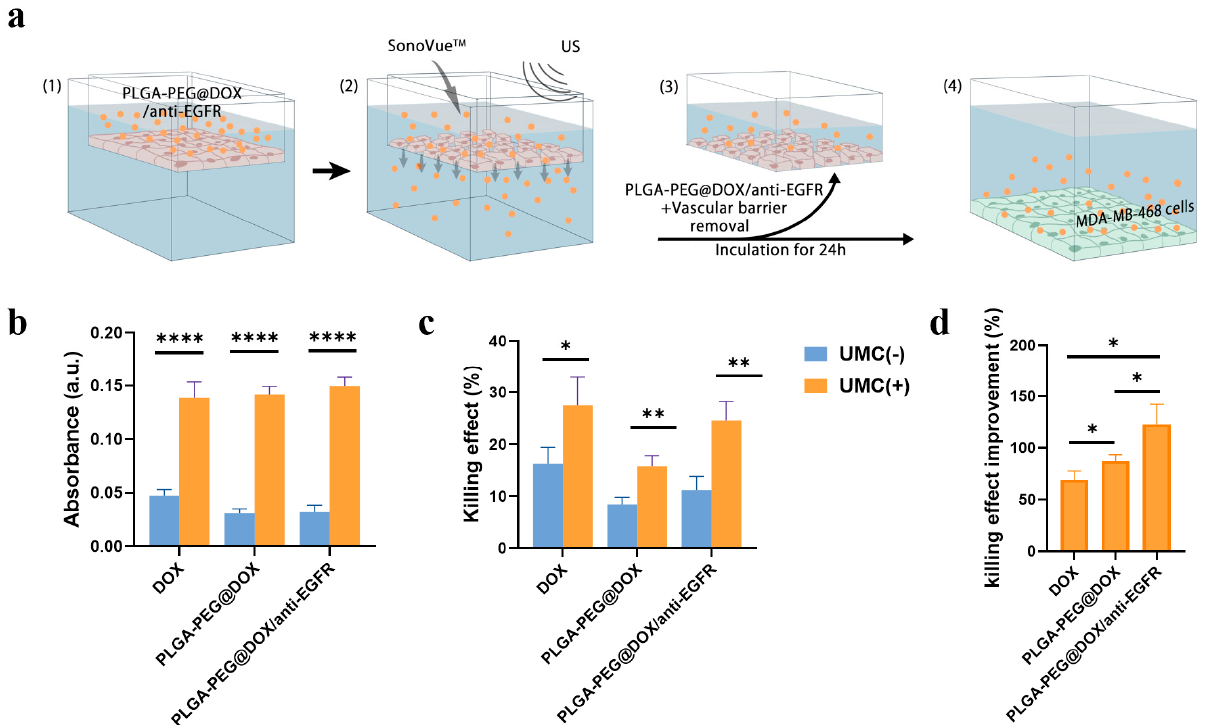
Figure 2. Ultrasonic cavitation-induced vascular permeability enhances DOX delivery to tumor cells. ( a ) Experimental overview: (1) free DOX, PLGA-PEG@DOX, or PLGA-PEG@DOX/anti-EGFR nano-micelles were added, after which (2)